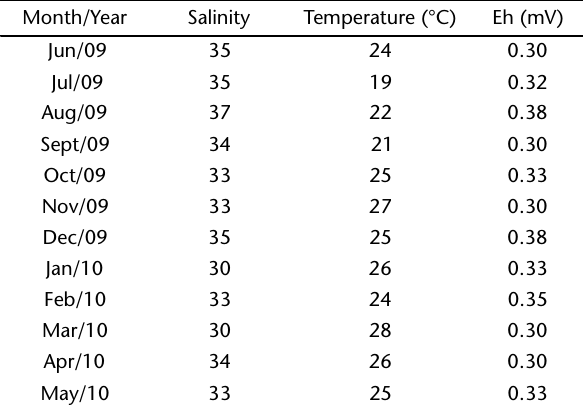
Table I. Abiotic data in the moment of sampling from the Man- guinhos beach, between June 2009 and May 2010.